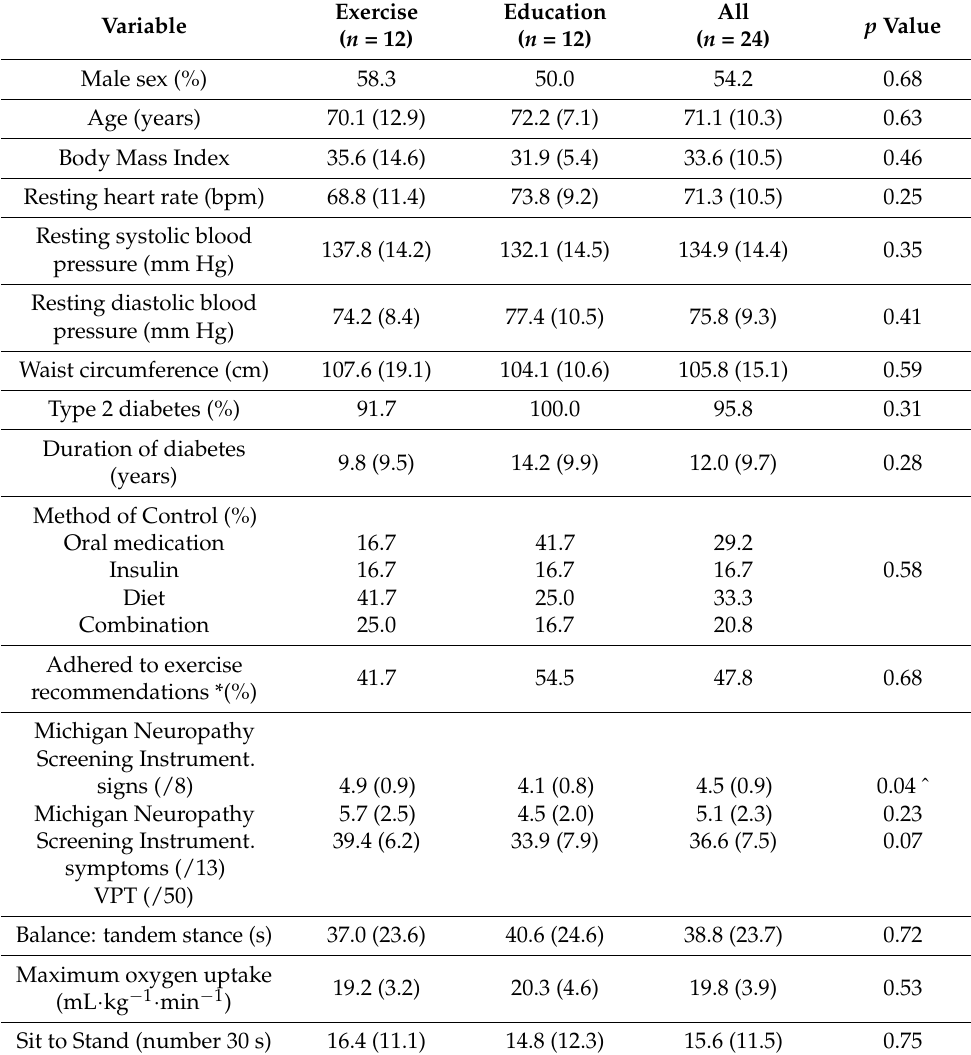
Table 1. Participant characteristics at